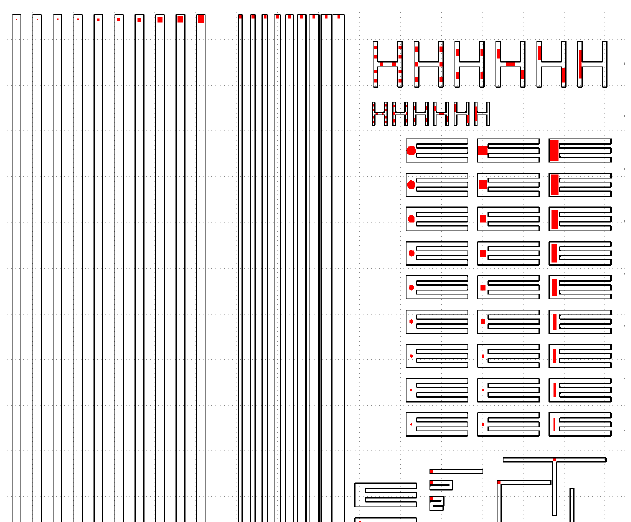
Figure 2. Mask-layers (black line: trench mask, red area: etch-access) for etch experiments. Some examples narrow/wide lines, dense/isolated.